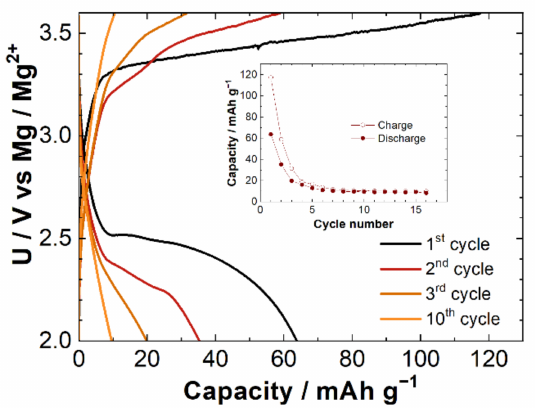
Figure 2. Galvanostatic cycling in 0.6 M Mg(TFSI) 2 /diglyme electrolyte at C/20.